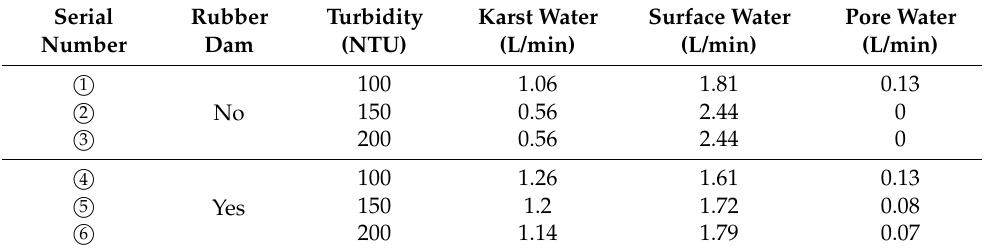
Table 4. Experimental results of suspended particles.